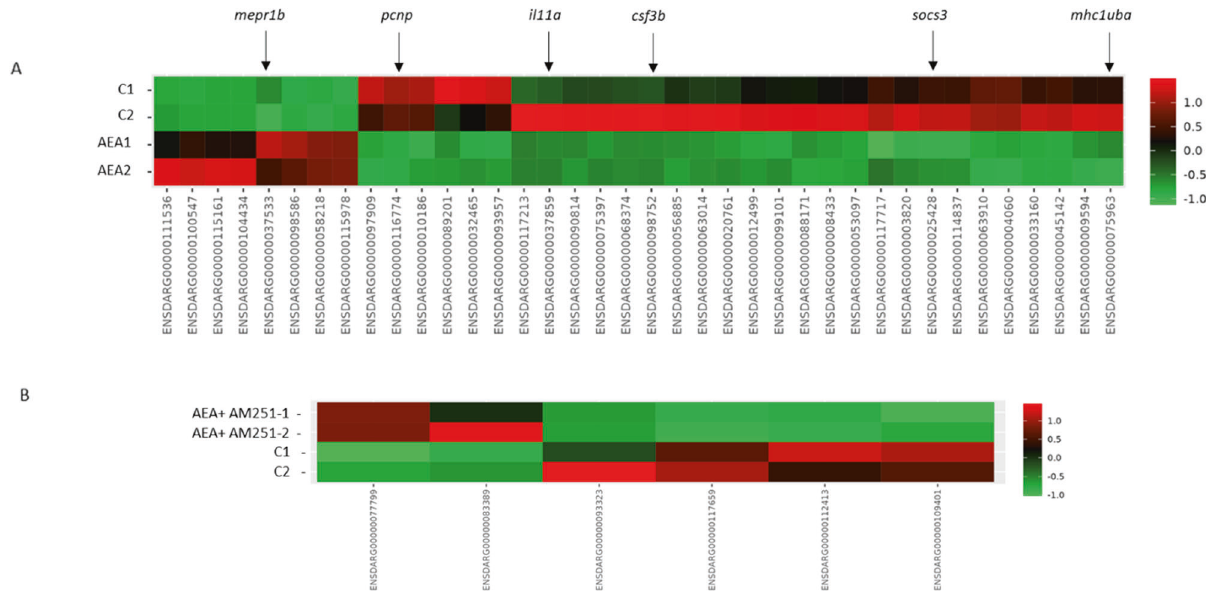
Fig. 4 Heatmaps showing the list of DEG in zebra fi sh xenograft exposed to AEA and AEA + AM251. A AEA vs. Ctrl. B AEA + AM251 vs. Ctrl. Color scales represent fold-change between two groups as described (green = downregulation, red = upregulation). Only signi fi cant DEGs (FDR < = 0.05) have been included. Arrows show DEGs analyzed in this study.